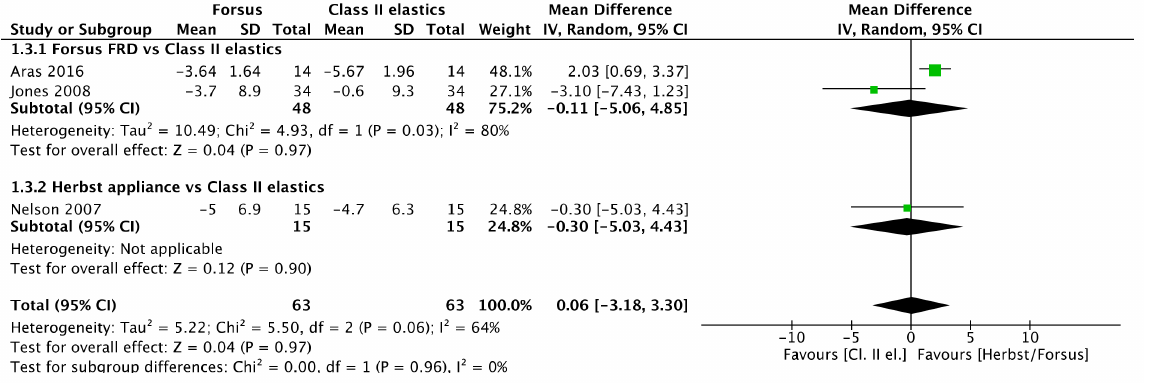
Figure 4. Forest plot of the upper incisor inclination changes using the random effects model [39,41,46].